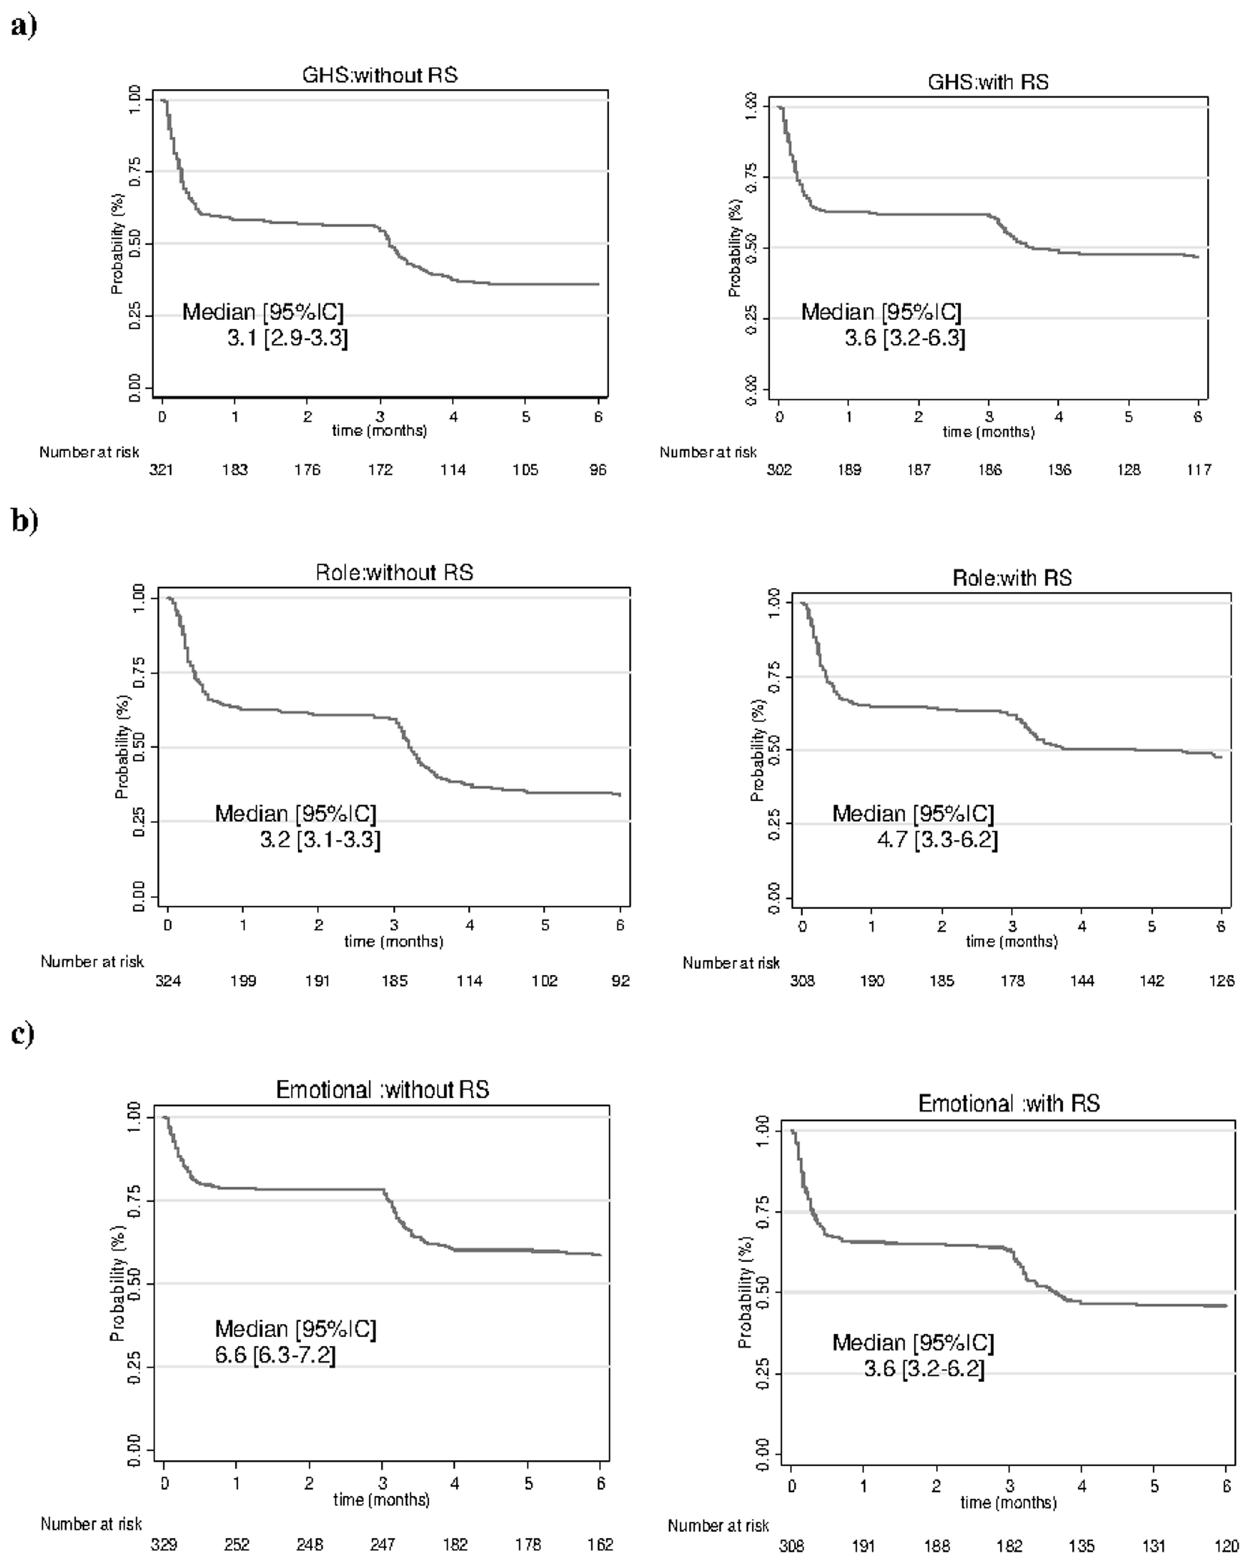
Figure 2. Time to deterioration in QoL score in the studied population with response shift (RS) taken into account or not. a) for the general health score of the QLQ-C30. b) for the role functioning score of the QLQ-C30. c) for emotional functioning. d)for social functioning. e) for body image. f) for systematic therapy side effects.